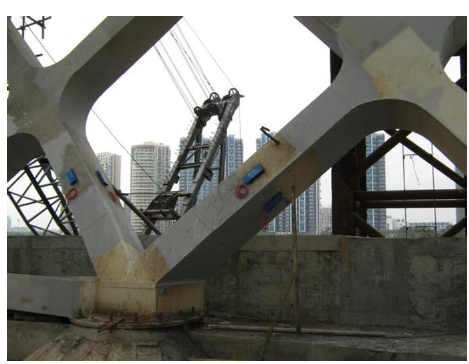
Figure 2. Distribution of the stress sensor.